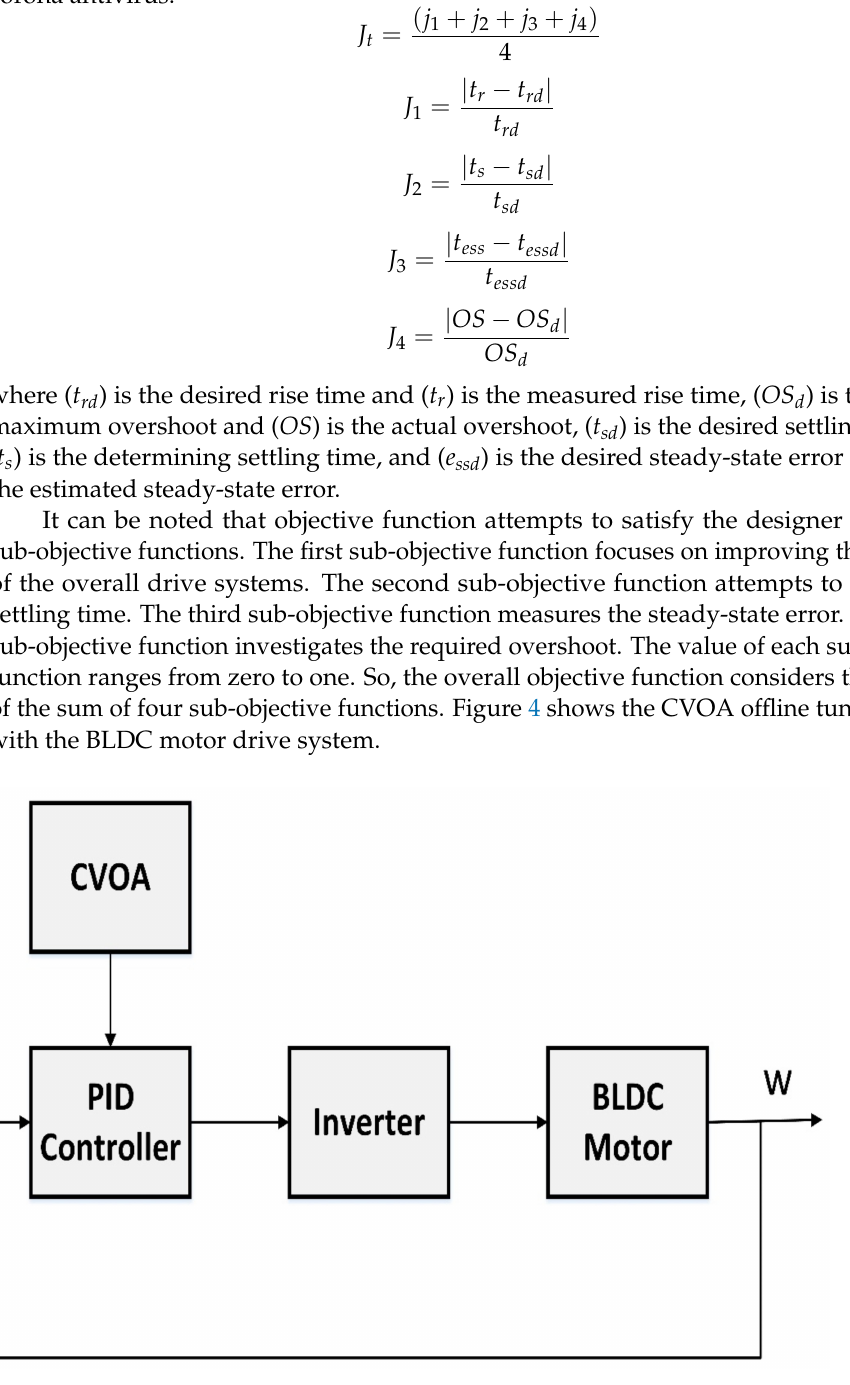
Figure 4. The CVOA tuning system with BLDC motor drive